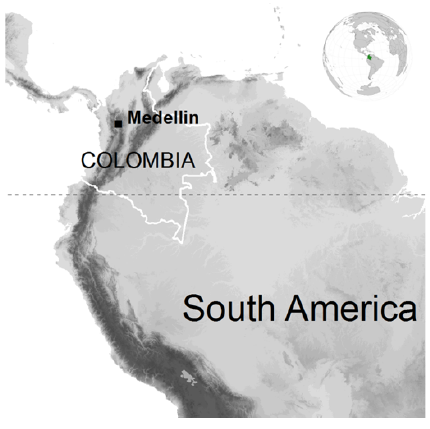
Figure 1. Medellin location map.